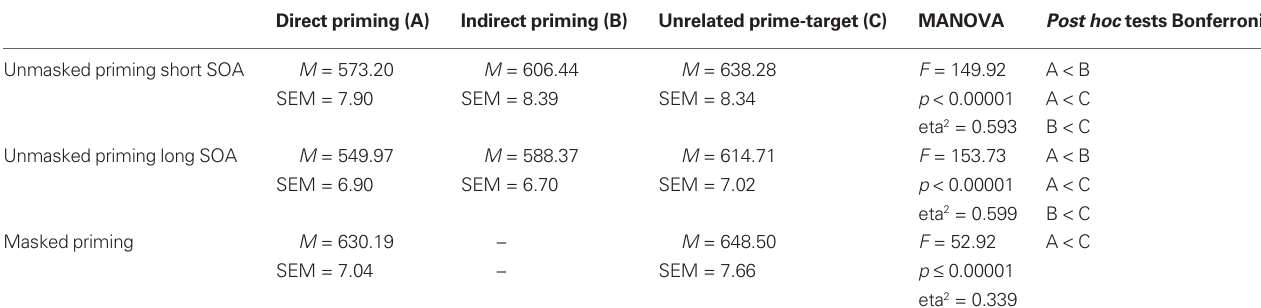
Table 1 | Priming